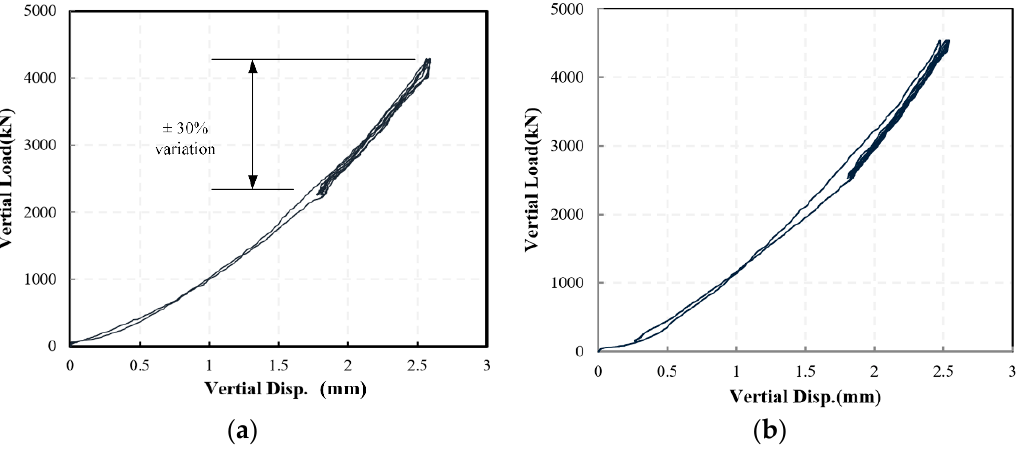
Figure 6. The force ‐ deformation curve of ( a ) NRB ‐ 600 and ( b ) LRB ‐ 600 specimen under vertical Figure 6. The force‑deformation curve of ( a ) NRB‑600 and ( b ) LRB‑600 specimen under vertical loads. loads Table 4. Mechanical properties of the specimen obtained in the vertical compression